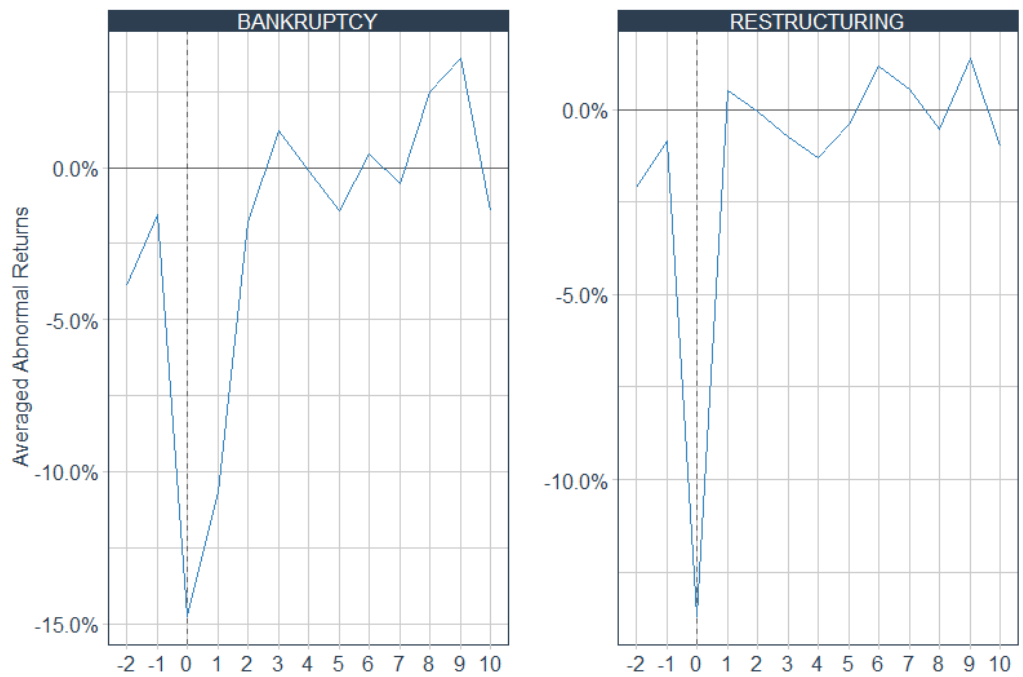
Figure 2. Average rates of return in the test window depending on the type of application submitted. Source: Own calcu- lations.